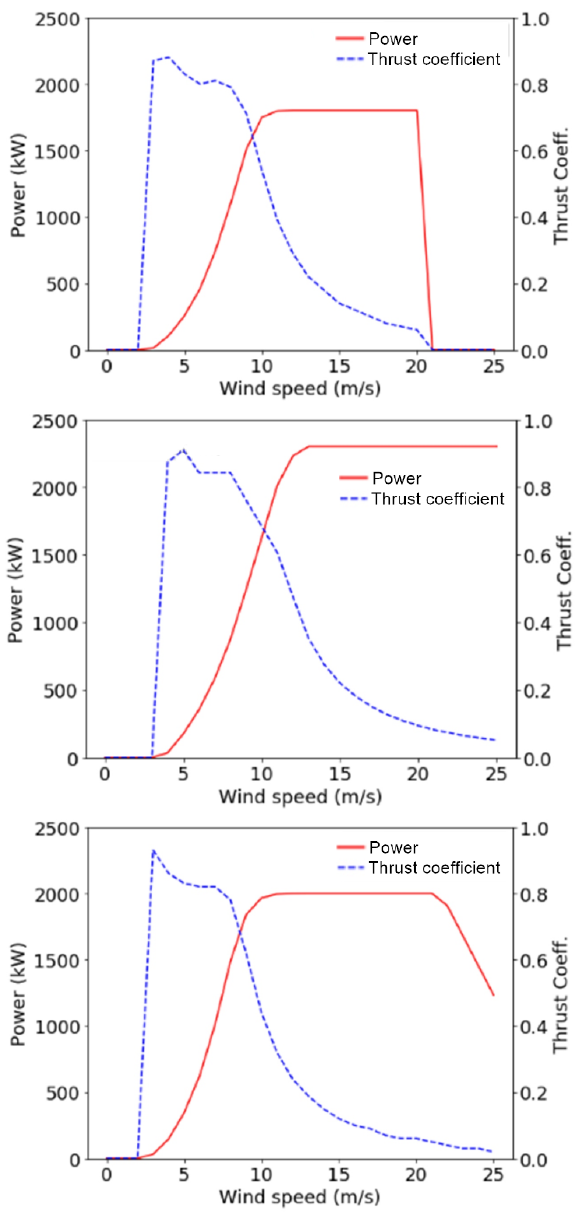
Figure 7. Power curves of selected wind turbines A ( top ), B ( middle ), and C ( bottom ).